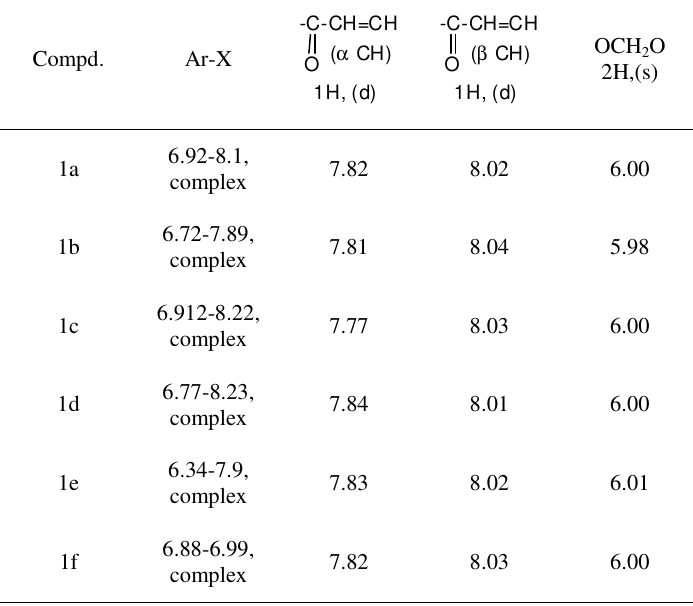
Table-2 . 1H NMR Data of Title Compounds (in d , ppm)